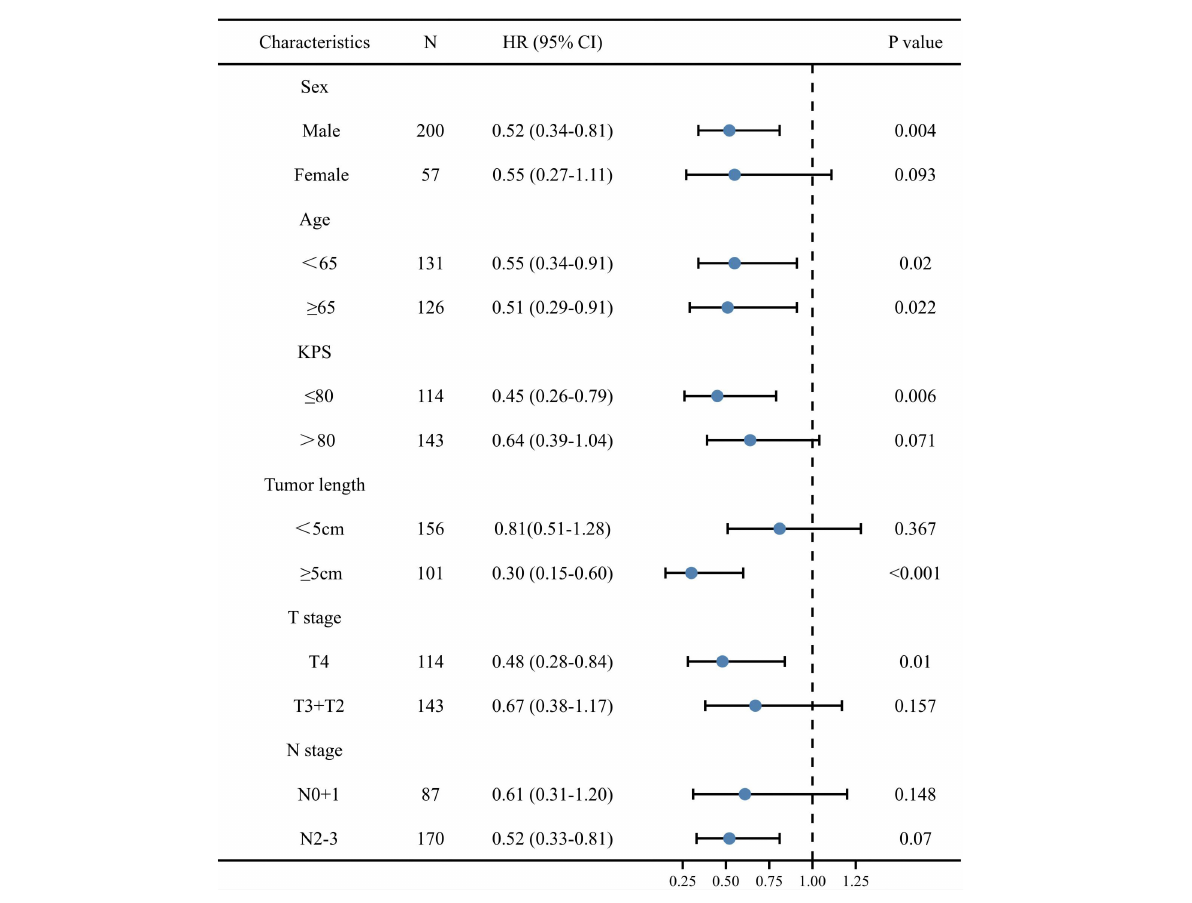
FIGURE3 A forest plot of overall survival (OS) for various patient subgroups of esophageal squamous cell carcinoma. CI, confidence interval; HR, hazard ratio; KPS, Karnofsky performance